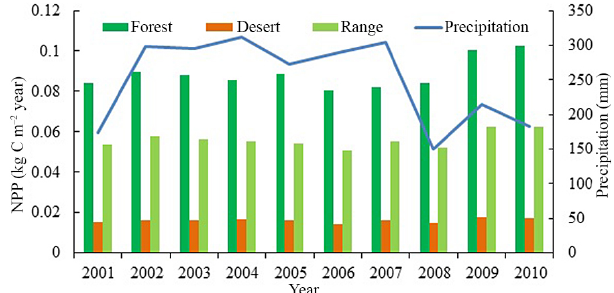
Figure 9. Average NPP changes of each type of land use regarding the annual average rainfall changes.